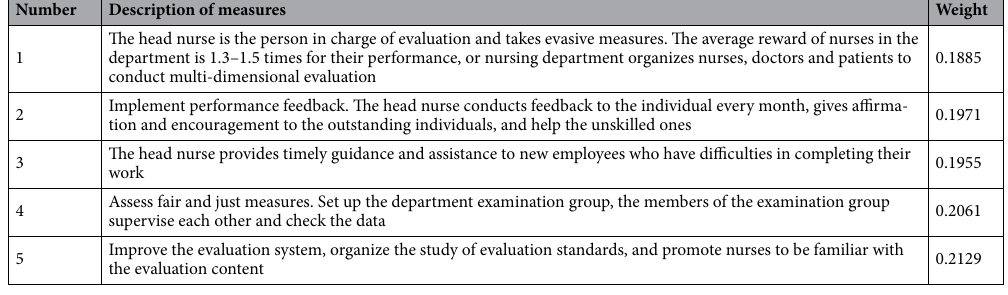
Table 5. Performance evaluation hygiene factors measures